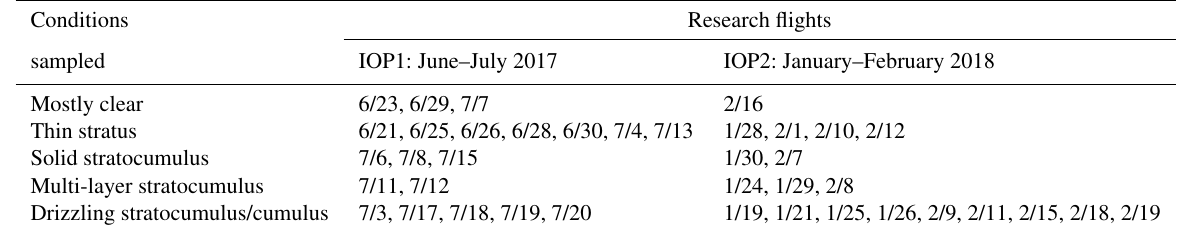
Table 2. Conditions of MBL sampled during the two IOPs of the ACE-ENA campaign. Dates are given in month and day (m/dd) format. Conditions Research flights